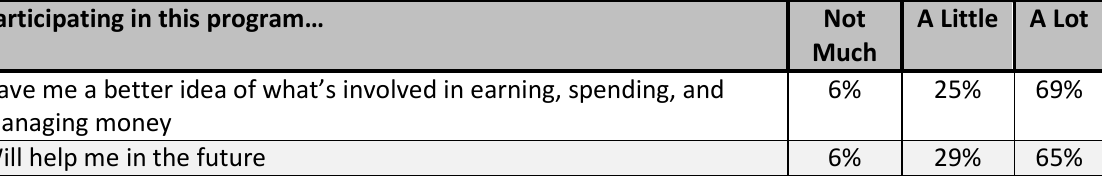
Overall Benefits